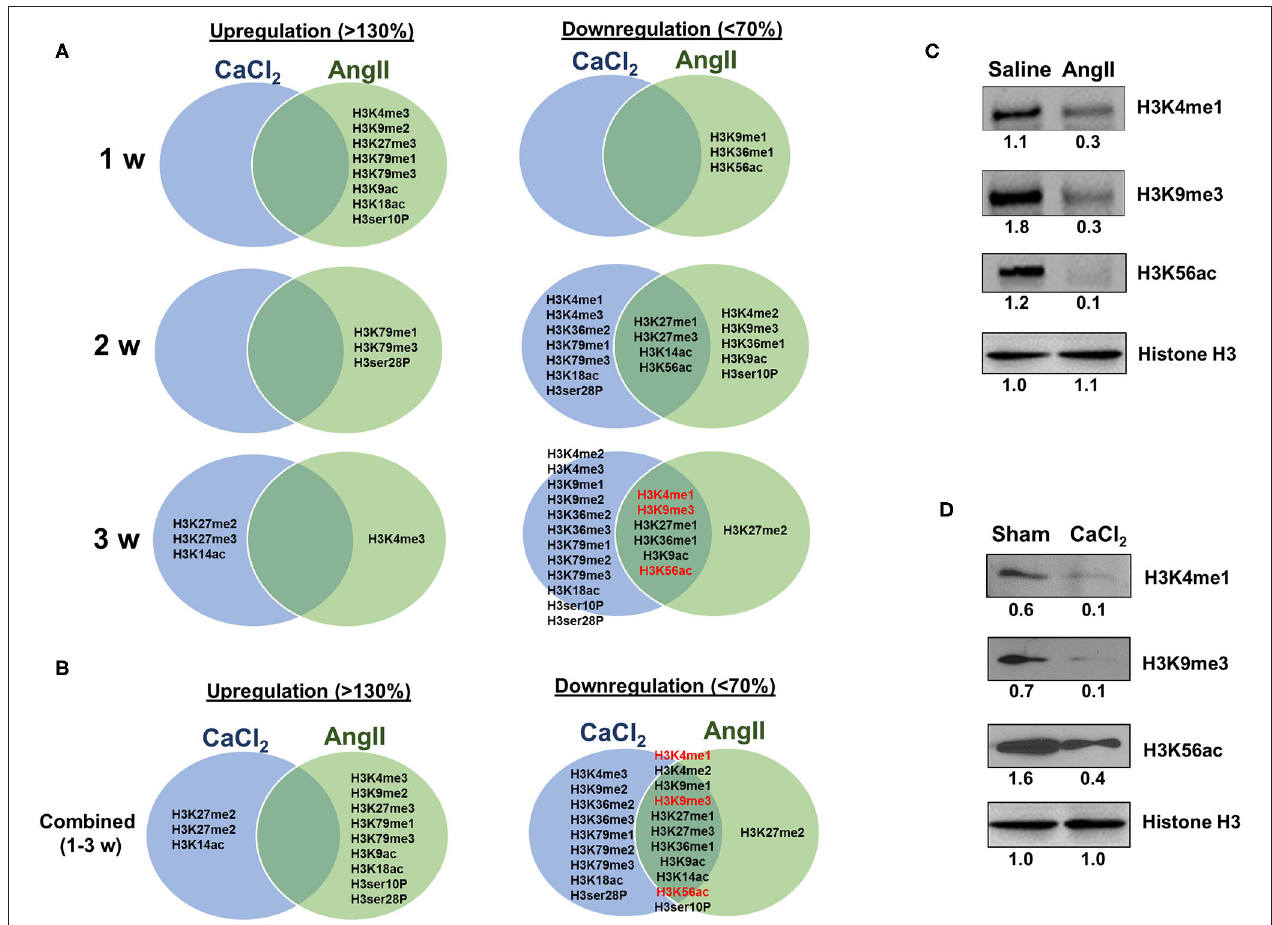
FIGURE 5 | Comparing H3 modifications between AngII- and CaCl 2 -induced AAA. (A) Summary of upregulated ( > 130%) and downregulated ( < 70%) histone H3 modifications in AngII- and CaCl 2 -induced AAA tissues in each time point (1, 2, 3 weeks, respectively). Venn diagram was used to demonstrate the overlapping histone H3 modifications between the two animal models of AAA. (B) Combined data at all time points (1–3 weeks). Key overlapping H3 modifications (H3K4me1, H3K9me3, and H3K56ac) in AngII-induced (C) and CaCl 2 -induced AAA (D) were verified by Western blot. Pooled aortic histone extracts from three mice were subjected to Western blot. Number represents the quantitative expression levels, normalized by histone H3 in saline or sham